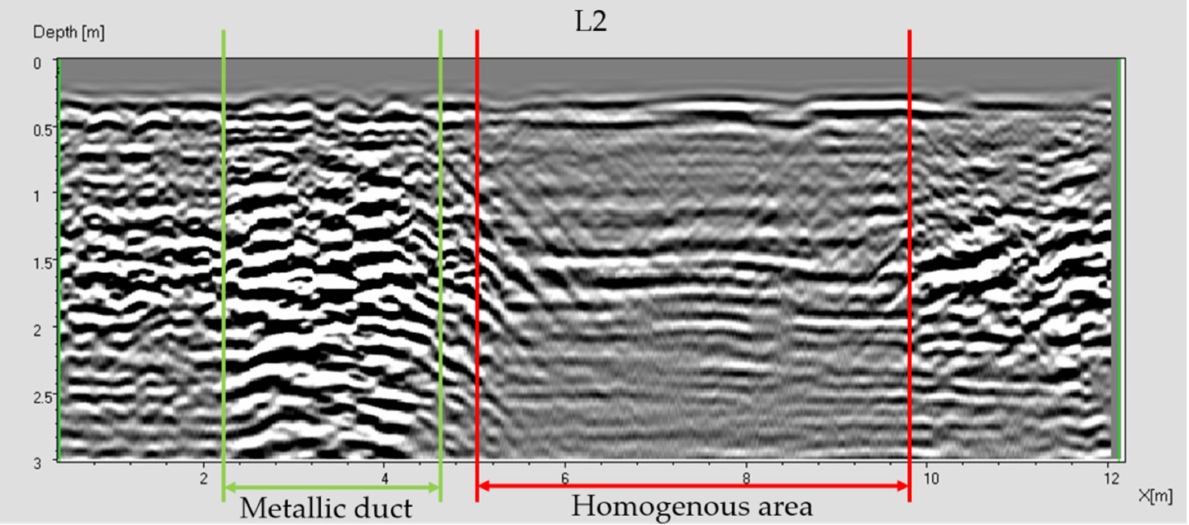
Figure 9. L2 B-scan.